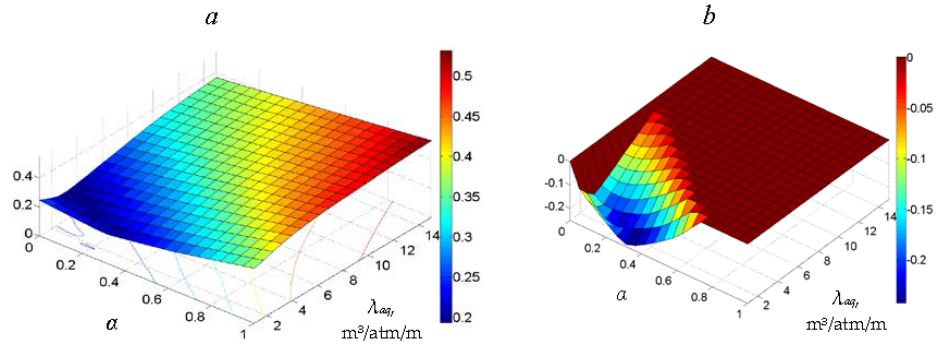
Figure 8. Comparison of the two types of objective functions J ( α , λ aq ) ( a ) and − J 1 ( α , λ aq ) ( b ).